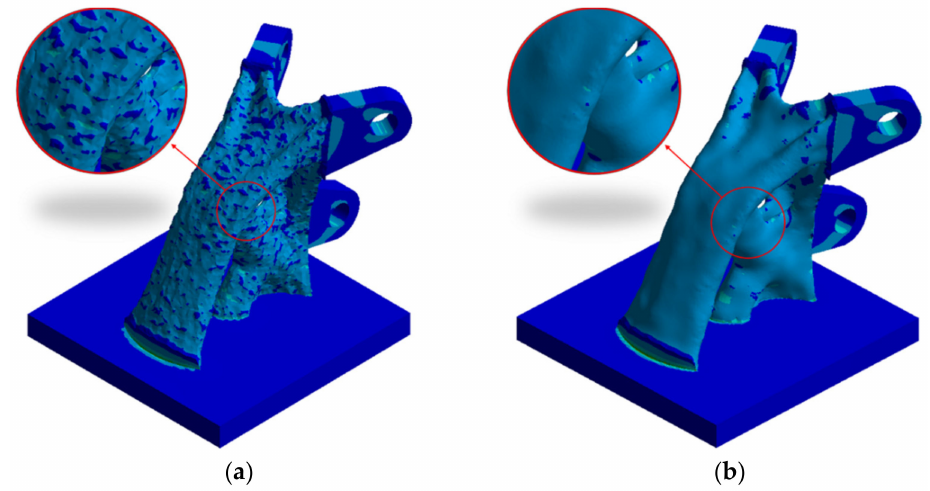
Figure 9. Comparison of the joint surface before and after smoothing: ( a ) before smoothing; ( b ) after